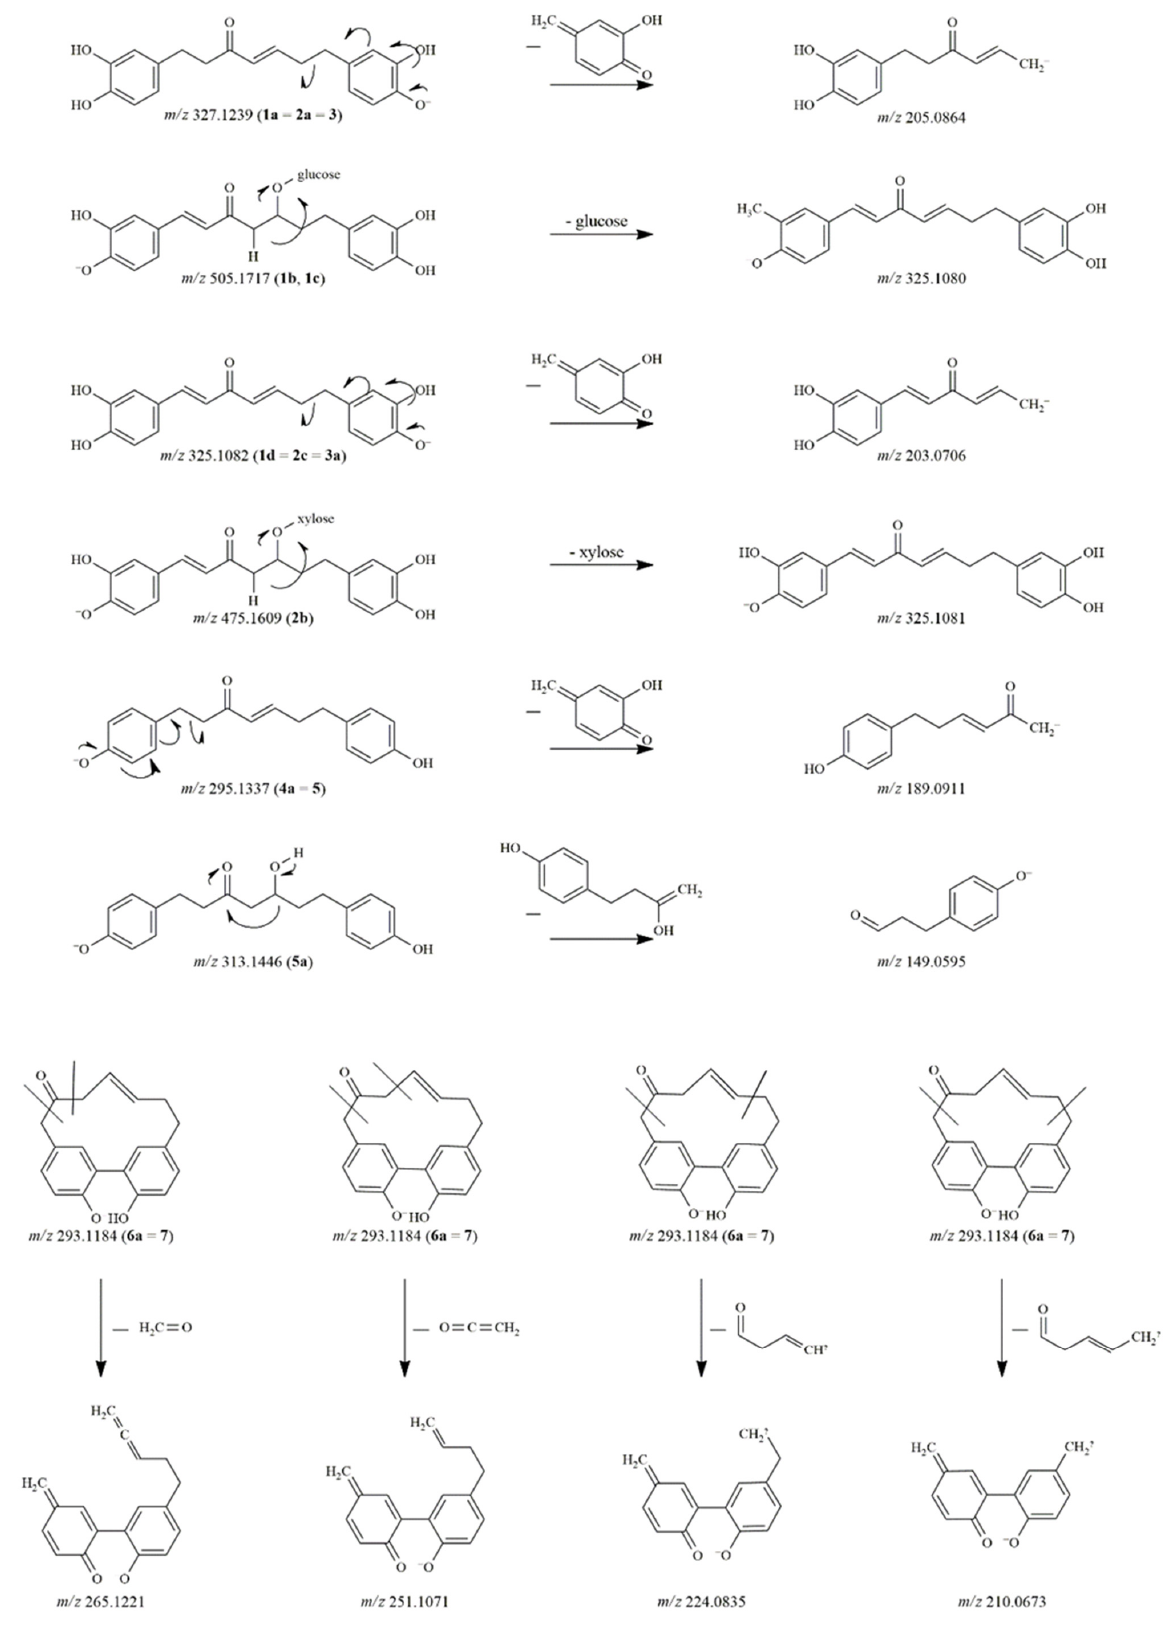
Figure 2. The proposed fragmentation pathways of diarylheptanoid degradation products.